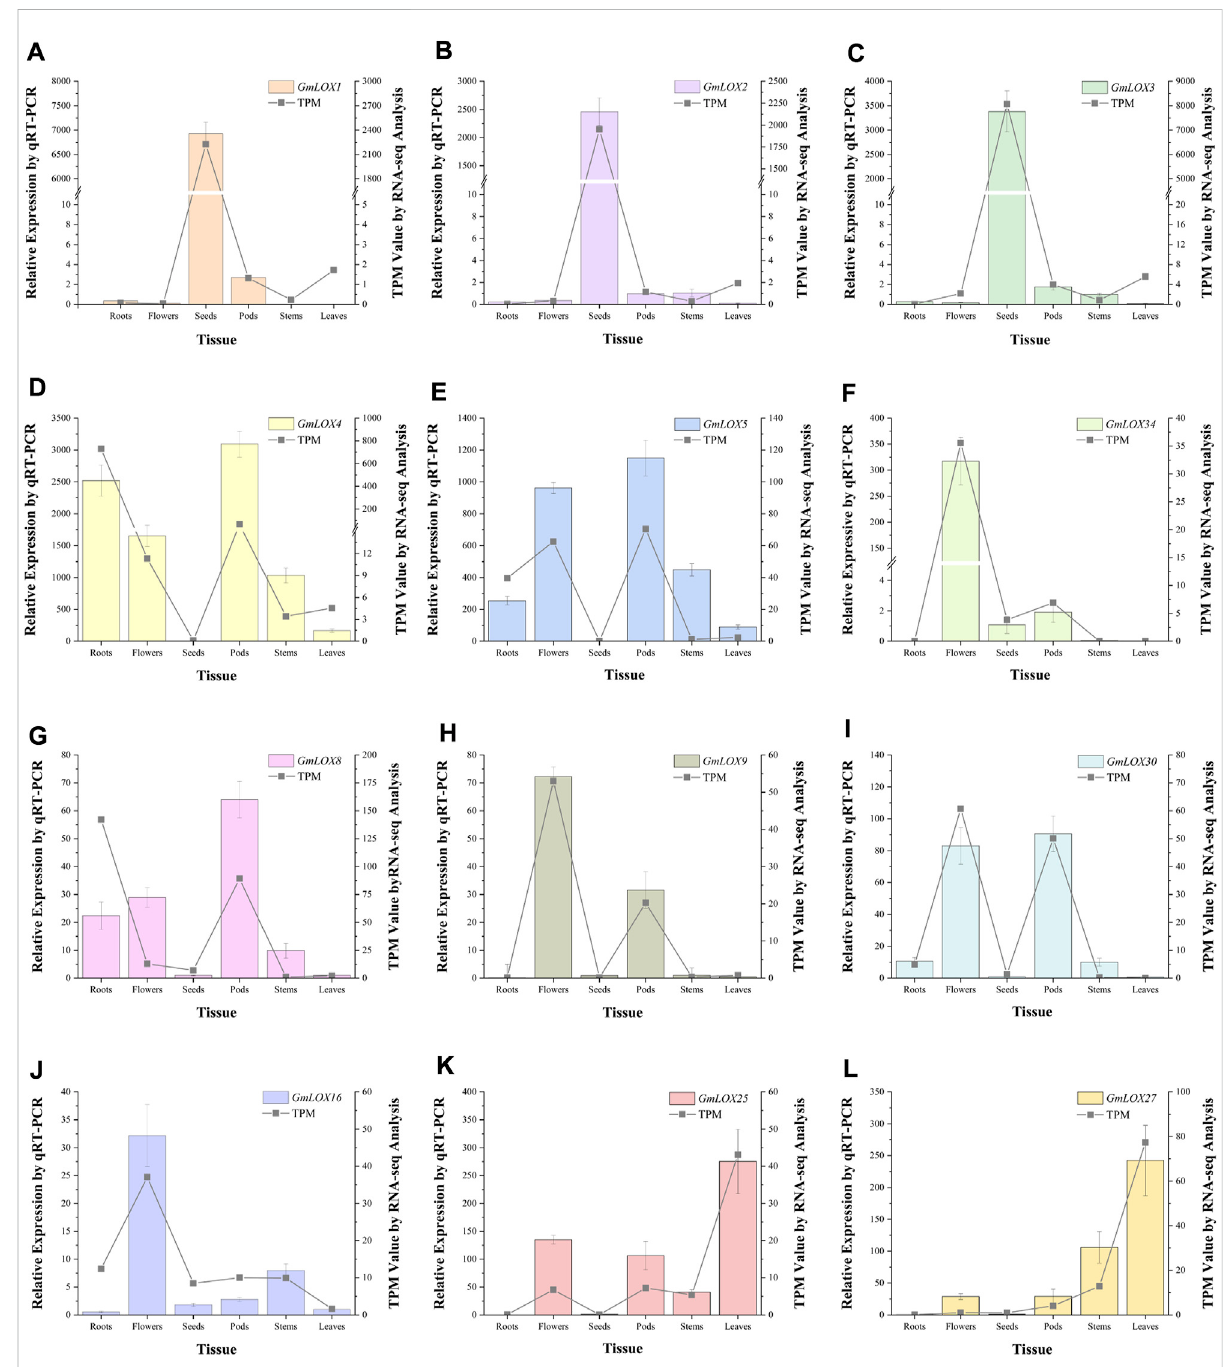
FIGURE 10 Twelve GmLOX genes were selected for qRT ‒ PCR analysis in different tissues Note: The left vertical axis represents the relative expression obtained by qRT ‒ PCR analysis, which is shown by the bar graphs in the fi gure. The standard deviation was calculated from the results of three independent experiments.The rightvertical axisis theTPM valuecalculated by RNA-seq analysis, which is presented intheform of line graphs inthe fi gure. Labels (A – L) show the qRT-PCR analysis results of GmLOX1 , GmLOX2 , GmLOX3 , GmLOX4 , GmLOX5 , GmLOX34 , GmLOX8 , GmLOX9